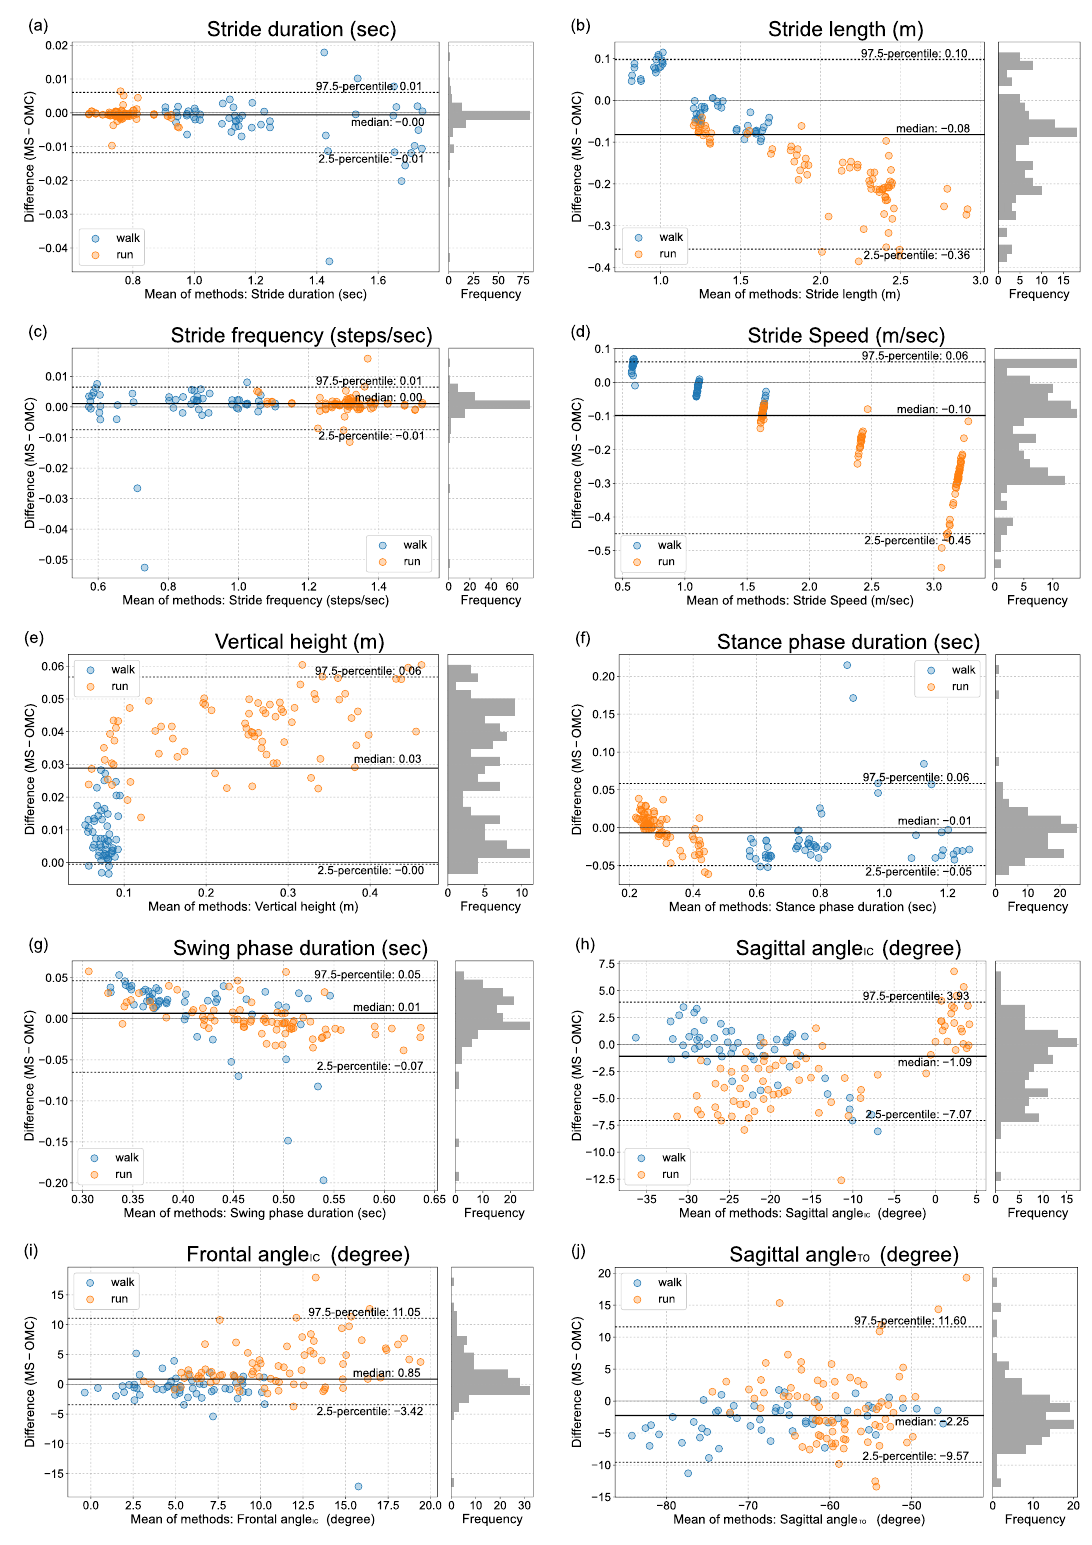
Figure 3. Bland–Altman plot of gait parameters from the motion sensor mounted on the shoe instep (instep-mounted) and optical motion capture ( a ) stride duration, ( b ) stride length, ( c ) stride frequency, ( d ) stride speed, ( e ) vertical height, ( f ) stance phase duration, ( g ) swing phase duration, ( h ) sagittal angle IC , ( i ) frontal angle IC , ( j ) sagittal angle TO , MS: motion sensor, OMC: optical motion capture.